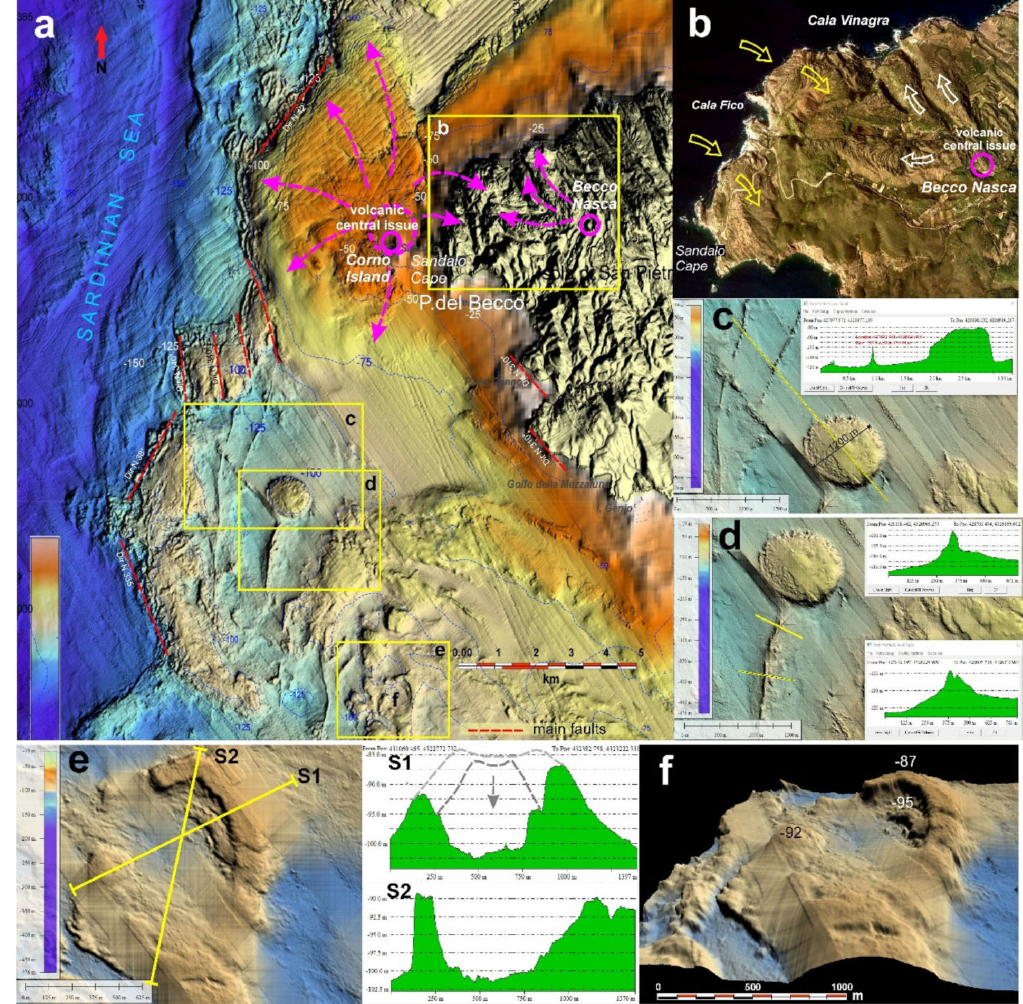
Figure 8. ( a ) Digital terrain model (DTM) from MBES data showing the drowned volcanic landforms in the continental shelf of San Pietro Island. The great volcanic edifice off Corno Island and the main fault sistems are highlighted. ( b ) Aerial photo of NW sector of San Pietro Island; the lava flow structures are evident from Becco Nasca source area (white arrows) and the lava structures from the volcanic edifice off Corno Island, currently submerged (yellow arrows). ( c ) DTM shadow relief and morphometric sections of a tabular volcanic structure (neck?). ( d ) DTM shadow relief and morphometric sections of mega-dikes, in relief due to differential erosion. These morphologies rise up to 12 m above the basal erosion surface, with longitudinal development up to 10 km. ( e ) DTM shadow relief and morphometric sections of a volcanic crater, showing a double collapse-rim structure. ( f ) Crater 3D model, the lowered internal flank and the central depression are